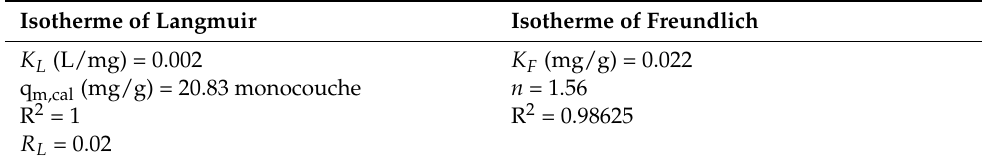
Table 5. The Freundlich and Langmuir models’ adsorption characteristics. Isotherme of Langmuir Isotherme of